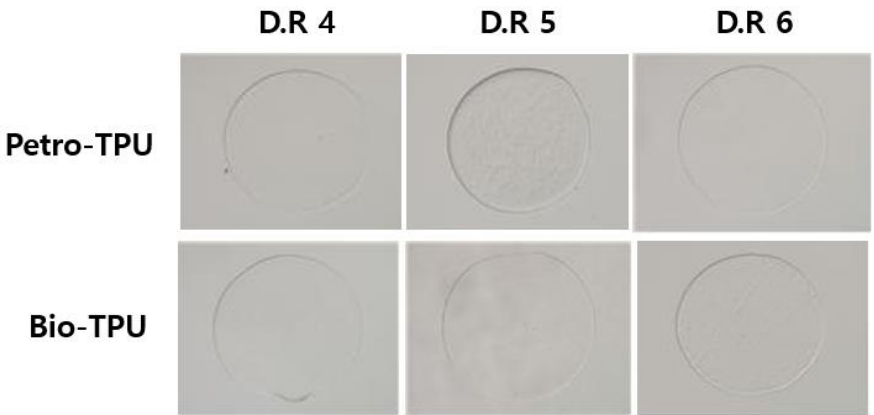
Figure 5. The cross-sectional shape of Petro-TPU and Bio-TPU according to draw ratios